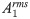
Frequency for activity total suppression (fs) and frequency for period doubling (fd), obtained from the reduced model.(A) Effect on the A1rms of increasing the pulse width δ from 0.5 ms to 3.5 ms. The dashed vertical lines indicate the frequency for activity total suppression fs determined from the A1rms curve. The solid vertical line indicates the frequency for period doubling fd determined from the β-Power curve (Fig 6A). (B) Transition frequencies fs (blue crosses) and fd (solid red circles) as functions of the H0DBS.δ product. The fs and fd values were determined from the A1rms plot (Fig 5A) and β-Power plot (Fig 6A), respectively. The analytical curve of fs values (solid blue line) is given by the Eq 16.